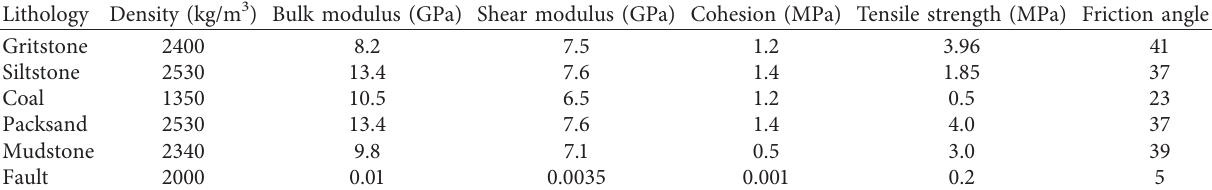
Figure 9: Schematic diagram of the three-dimensional numerical model. Table 3: Model strata and mechanical parameters.